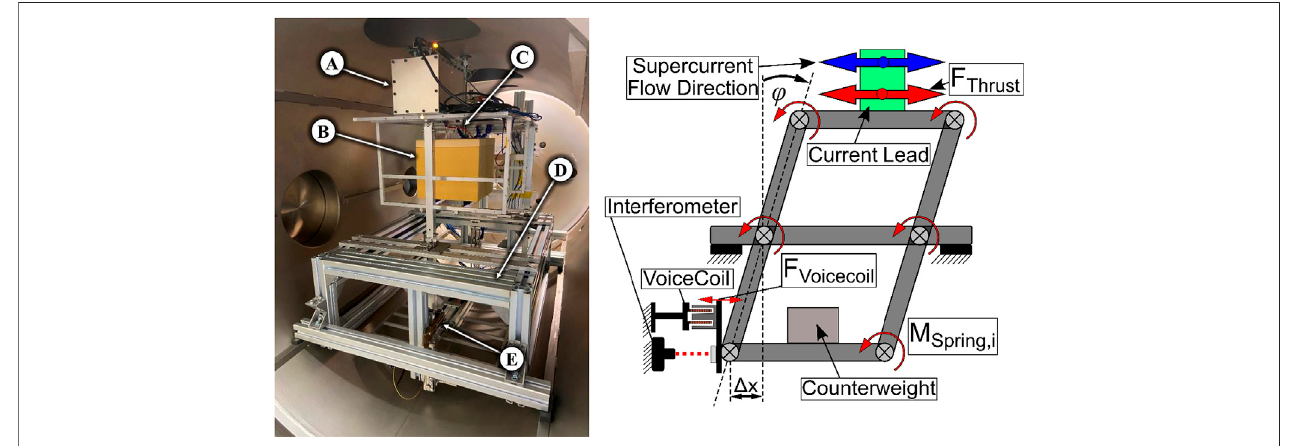
FIGURE3| ThrustBalance.Left:Electronicsinsideamumetalhousing (A) andthecryo-box (B) positionedbelowtheliquidnitrogenoutlet (C) onthethrustbalance (D) , which is fi xated with a bimetal actuator (E) . Right: Schematic illustration of the inverted counterbalanced double-pendulum principle. (adapted from Figure 1A in [20]).